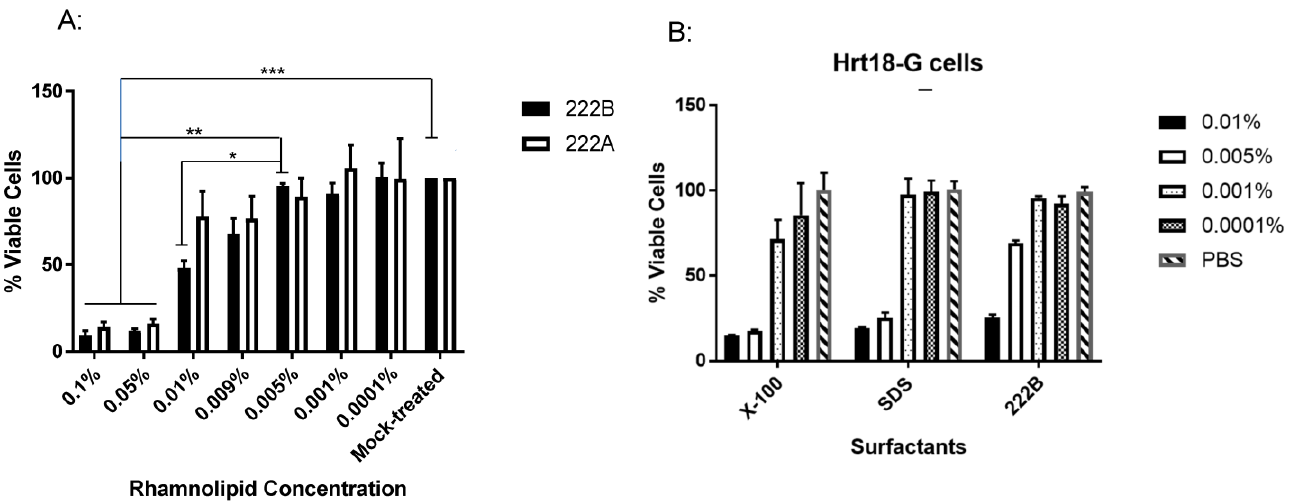
Figure 3. The cytotoxicity of Rhamnolipids in vitro. Vero cells ( A ) or Hrt-18 G cells ( B ) were incubated with the indicated concentration of rhamnolipids or surfactants in PBS for 1 h. The treatment was then removed, and the cells were washed twice with PBS and further incubated for 24 h in EMEM with 5% serum and antibiotics as described in materials and methods. Cell viability was evaluated with XTT cell viability kit III (PromoKine), which measures metabolic activity based on the extracellular reduction of XTT by NADH produced in the mitochondria, and expressed as a percentage of the Mock-treated control ( n = 3). A significant statistical difference from the PBS-treated control (Mock-treated) or 0.005% 222B (A) is marked with * p < 0.05, ** p < 0.001, *** p < 0.0001 (two-way ANOVA with Bonferroni post-test).